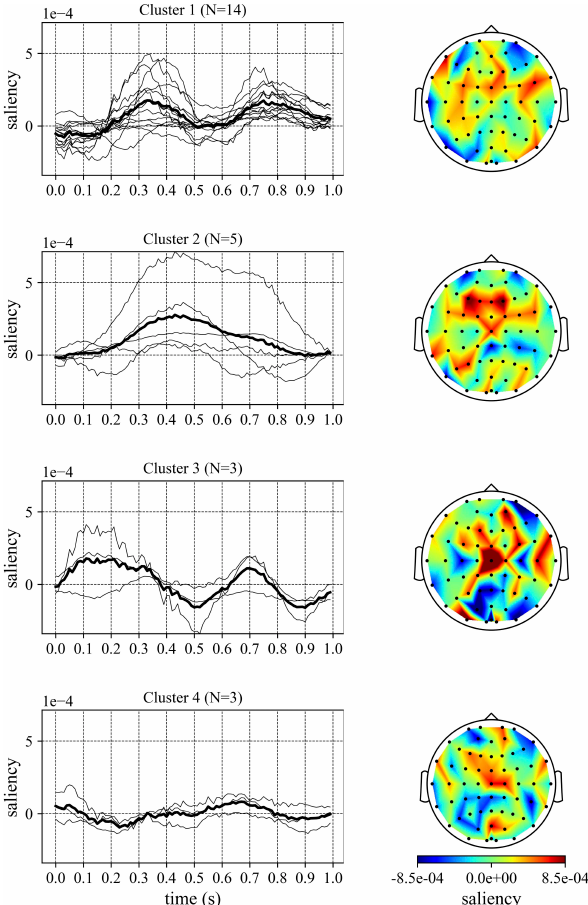
Fig. 8. Cluster analysis: target. For each cluster individuated by hierar- chical agglomerative clustering, the left panel displays the temporal cluster- specific saliency pattern (thick line) together with the temporal subject- specific saliency patterns (thin lines) defining each cluster, while the topo- logical map on the right displays the spatial cluster-specific saliency pattern.